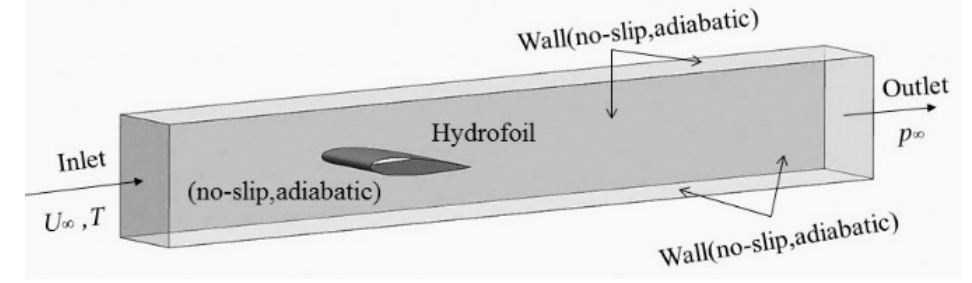
Figure 2. 3D model of the NACA0015 hydrofoil.